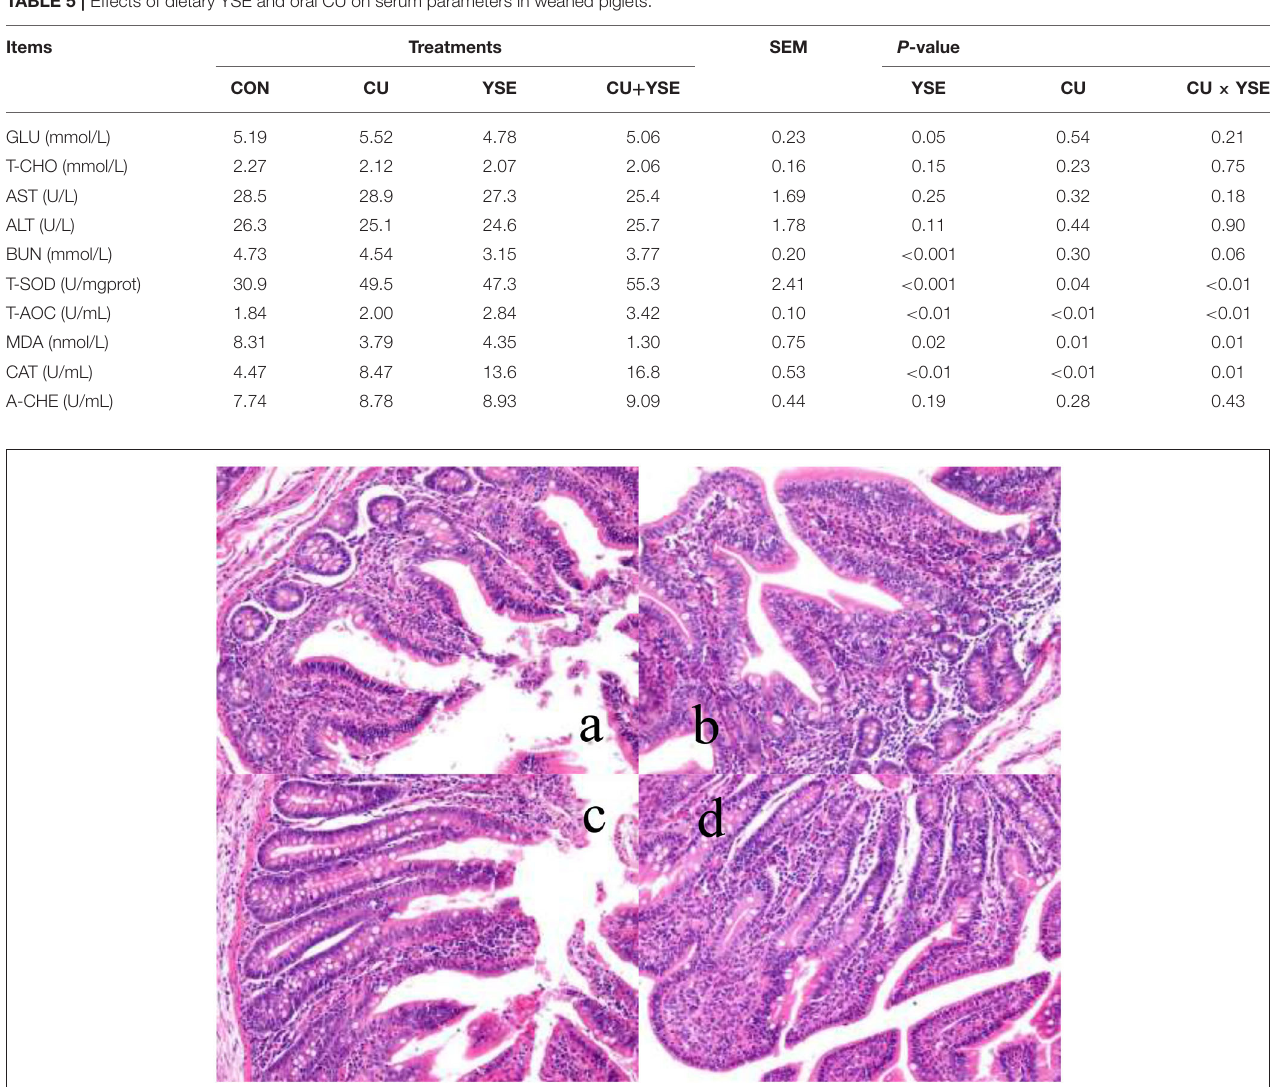
FIGURE 1 | The effects of dietary YSE and oral CU on villus height and crypt depth of ileum in weaned pigs ( × 400). (a) represents piglets fed basal diet and orally administered 1mL of 0.85% saline (CON), (b) represents piglets fed basal diet and orally administered 1mL 1 × 10 9 cfu/mL C. utilis in 0.85% saline (CU), (c) represents piglets fed the basal diet containing YSE (120 mg/kg) and orally administered 1mL of 0.85% saline (YSE), (d) represents Piglets fed the basal diet containing 120 mg/kg YSE and 1mL 1 × 10 9 cfu/mL C. utilis in 0.85% saline (YSE +